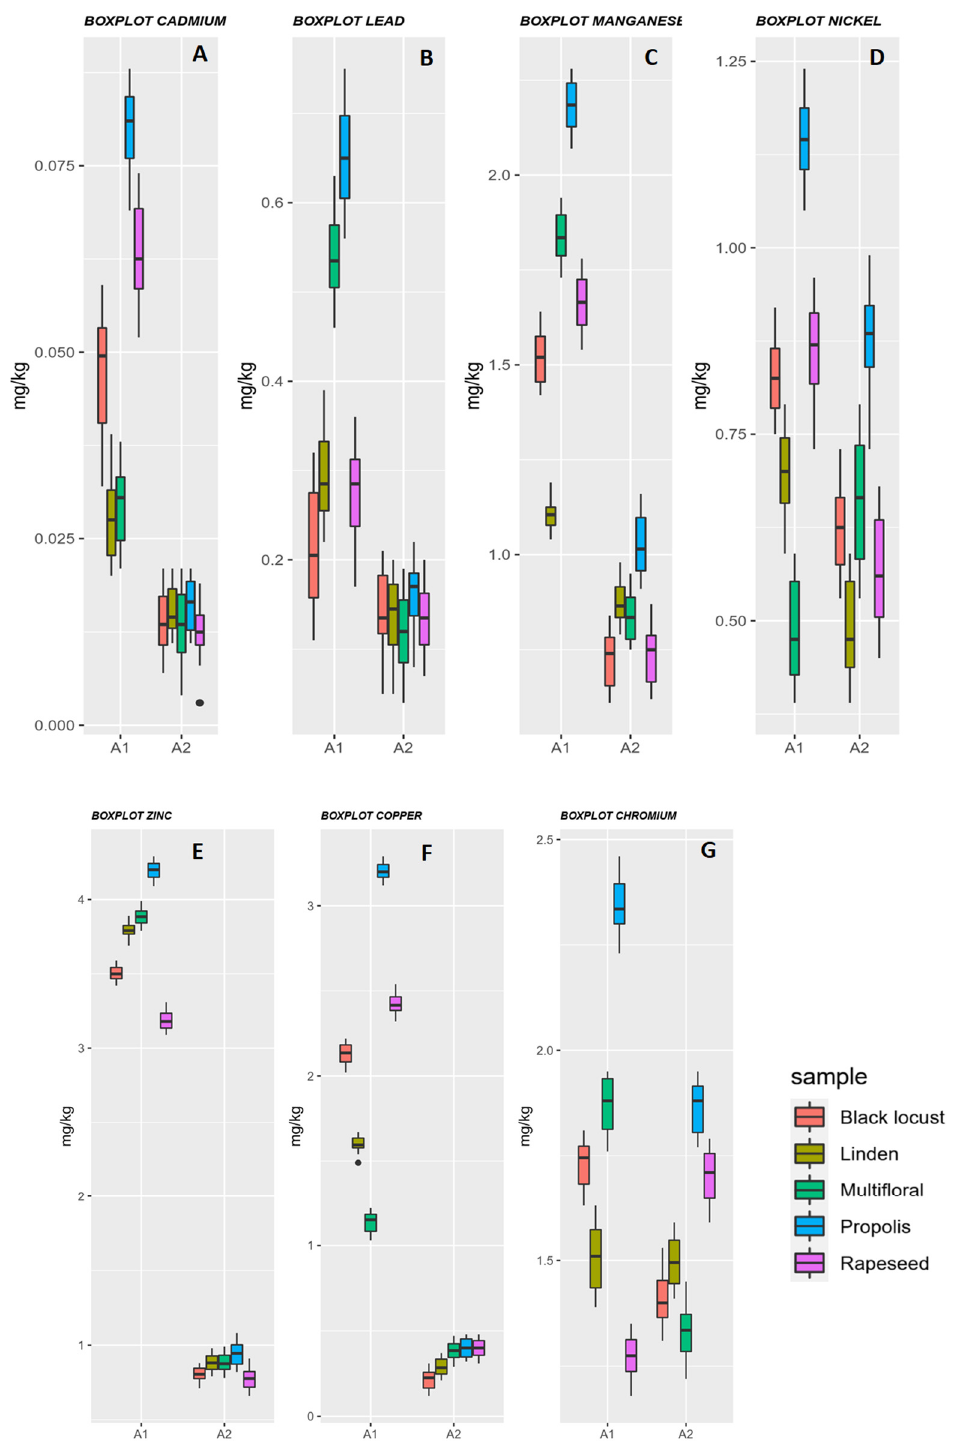
Figure 1. Heavy metal level variations (mg/kg) in honey samples in A1 (industrial activity) and A2 (agricultural activity) areas: ( A ) nickel, ( B ) chromium, ( C ) zinc, ( D ) copper, ( E ) cadmium, ( F ) lead and ( G ) manganese.